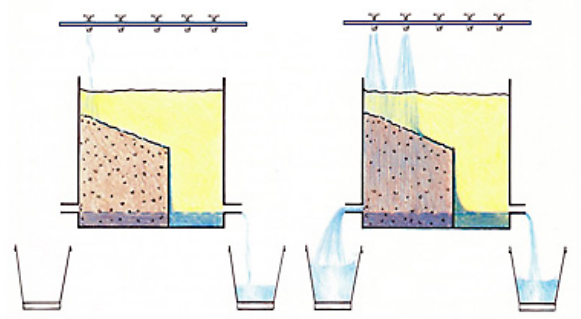
to show the effect of a coarse layer on unsaturated flow. The flows are greatly exaggerated in this principle sketch (Modified from Grip and Rodhe,